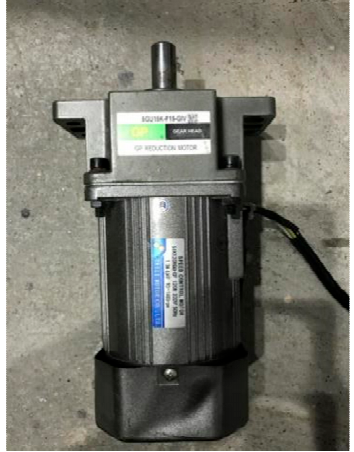
Figure 4. Photo of YVF-6314 adjustable motor.